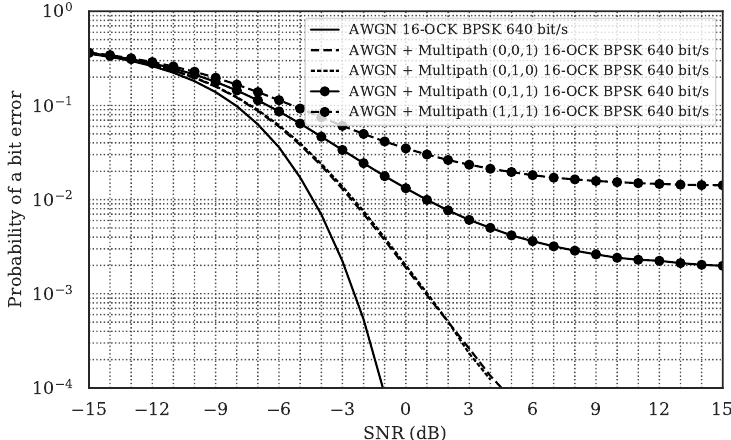
Figure 6. Simulated BER vs. SNR for 16-OCK BPSK in AWGN + multipath channels. Multipath configurations: (A,B,C), where position A = 2, B = 34, C = 67 chips delay. The value indicates relative amplitude compared to the direct